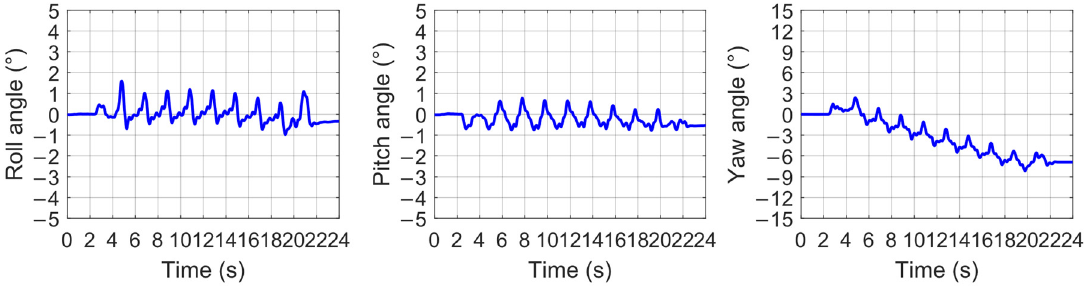
Figure 14. Attitude variations in tripod gait (no correction).